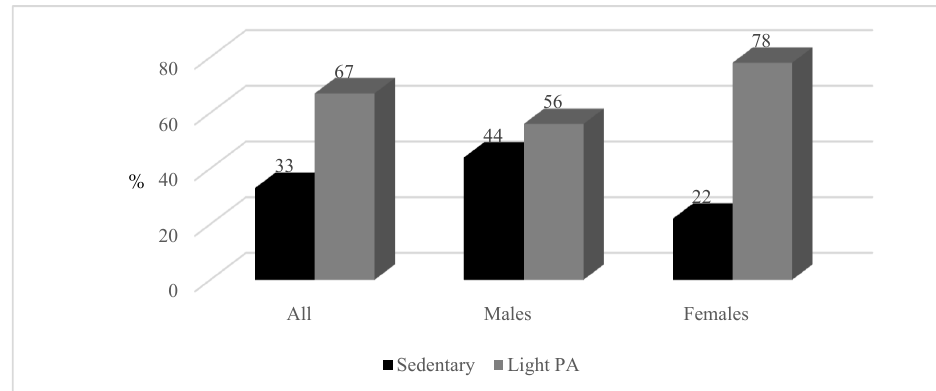
Figure 3. Percentage (%) scores for physical activity.